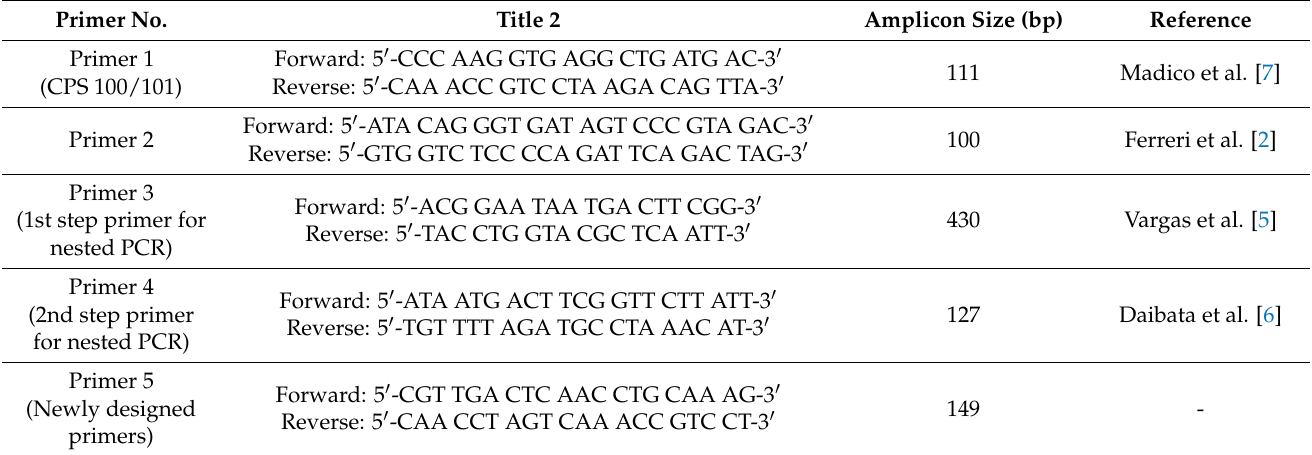
Table 1. Primer sets for polymerase chain reaction detection of Chlamydophila psittaci . Primer No.